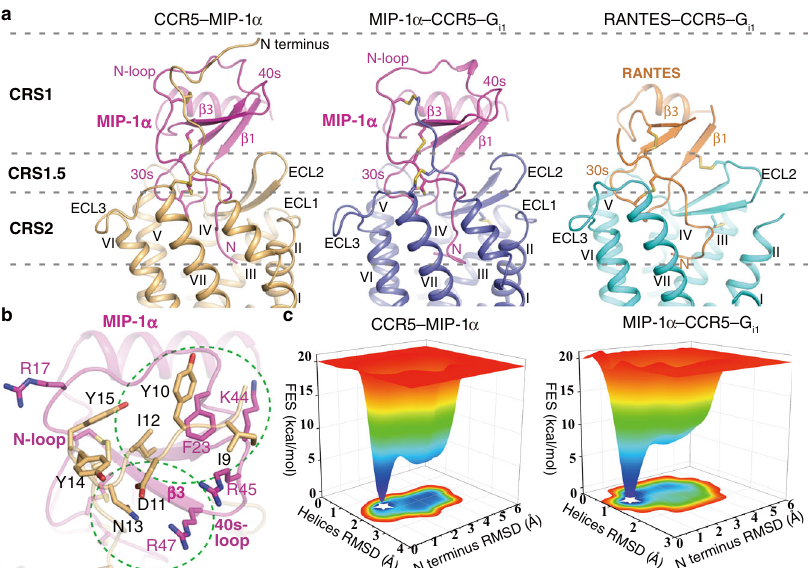
Fig. 2 Overall chemokine binding mode in CCR5 and receptor-chemokine recognition in CRS1. a Overall chemokine binding mode in CCR5. The structures of CCR5 – MIP-1 α , MIP-1 α – CCR5 – G i1 , and RANTES – CCR5 – G i1 are shown in cartoon representation. The receptors in the three structures are colored gold, blue, and cyan, respectively. The chemokines MIP-1 α and RANTES are colored magenta and orange, respectively. The regions of CRS1, CRS1.5, and CRS2 are indicated by gray dashed lines. b The receptor-chemokine interactions in the CRS1 of the CCR5 – MIP-1 α structure. The key residues of CCR5 and MIP-1 α that form contacts are shown as sticks with gold and magenta carbons, respectively. The two interaction cores other than the interactions between the tyrosines in CCR5 and the basic residues in MIP-1 α are indicated by green dashed circles. c The free energy surface (FES) of the GaMD simulations of the CCR5 – MIP-1 α and MIP-1 α – CCR5 – G i1 complexes. The FES pro fi le was calculated along with the collective variables of the RMSDs of the CCR5 helices and N terminus. The experimentally identi fi ed binding states between MIP-1 α and the CCR5 N terminus are highlighted with white-colored stars. Source data are provided as a Source Data fi The third residues in the two chemokines vary in their side